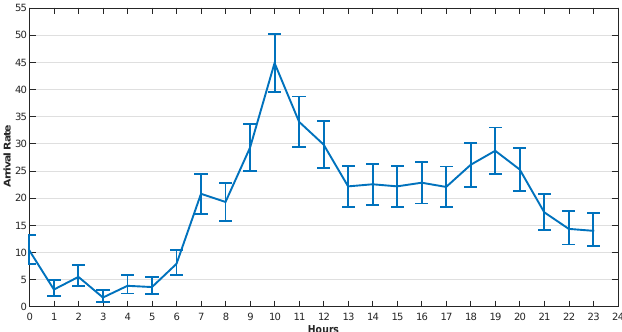
Figure 8. The Arrival Rate in 24 h, Square id 10000, Milan, 1 November